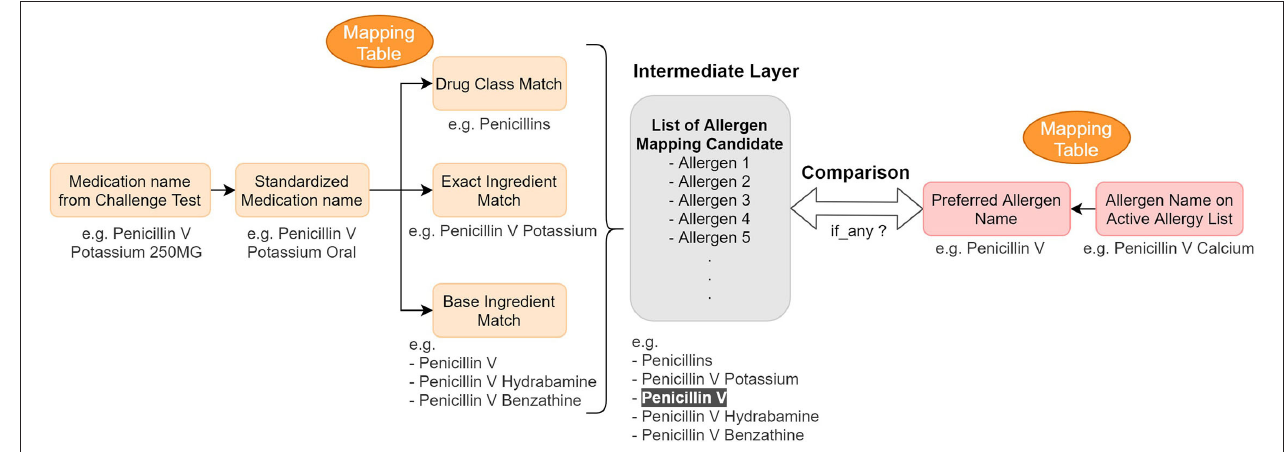
FIGURE 3 | Concept mapping for the reconciliation mechanism—logic and example. We used mapping tables to map (1) medication name in a challenge test to different drug hierarchy relationship ( 2) active allergen to their preferred name. Then we compared them to find any information